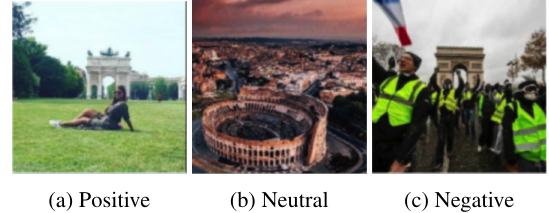
Figure 2. Images from CHRIS Dataset. Figure 2a is an example of positive image, Figure 2b represents an image with neutral sentiment, and Figure 2c is a picture with negative sentiment.